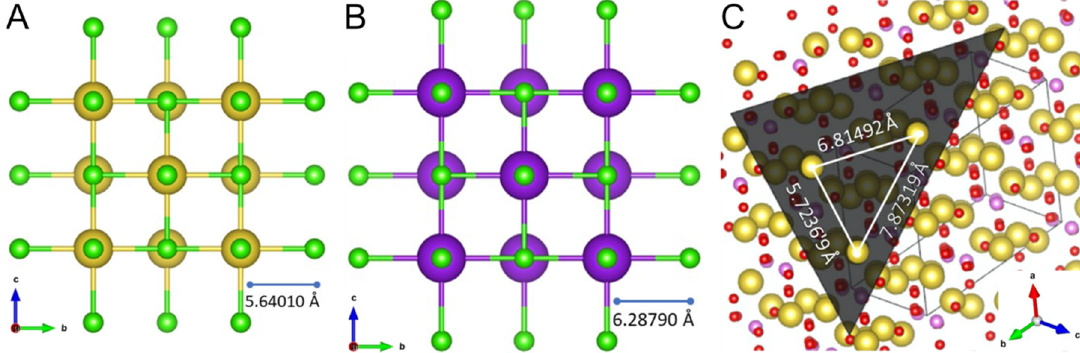
Figure 7. Projection of (100) planes of ( a ) NaCl, ( b ) KCl, and ( c ) plane (111) of Na 2 SO 4 with Na depicted in yellow, K in purple, Cl in green, S in pink and O in red. Lattice parameters taken considering room temperature and pressure [37]. Projections made with VESTA software [39].